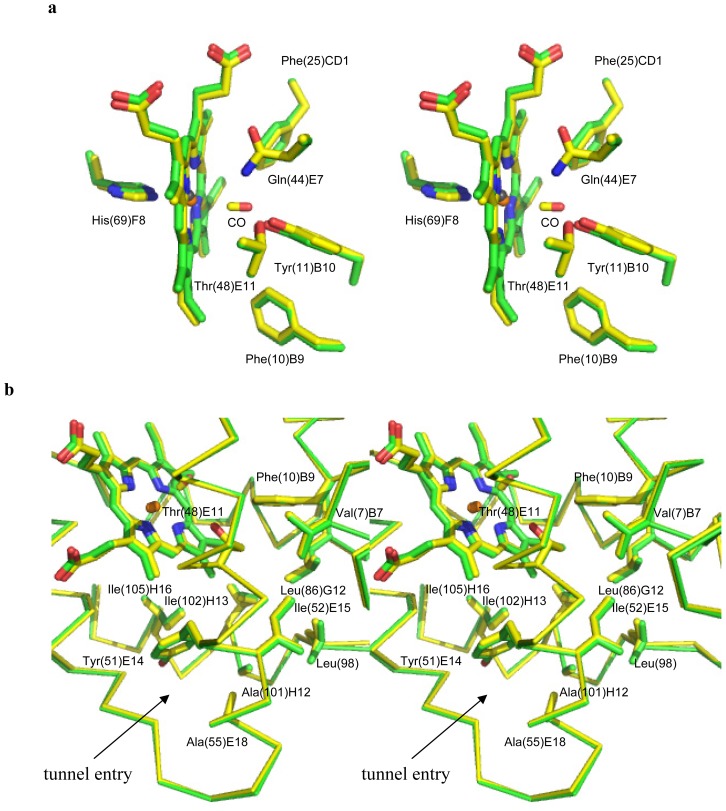
Stereo view of the structural superimposition of CerHb-CO (yellow) and unligated-CerHb (green) (a) at the distal site, and (b) at the apolar tunnel region. Relevant residues have been shown in stick representation.